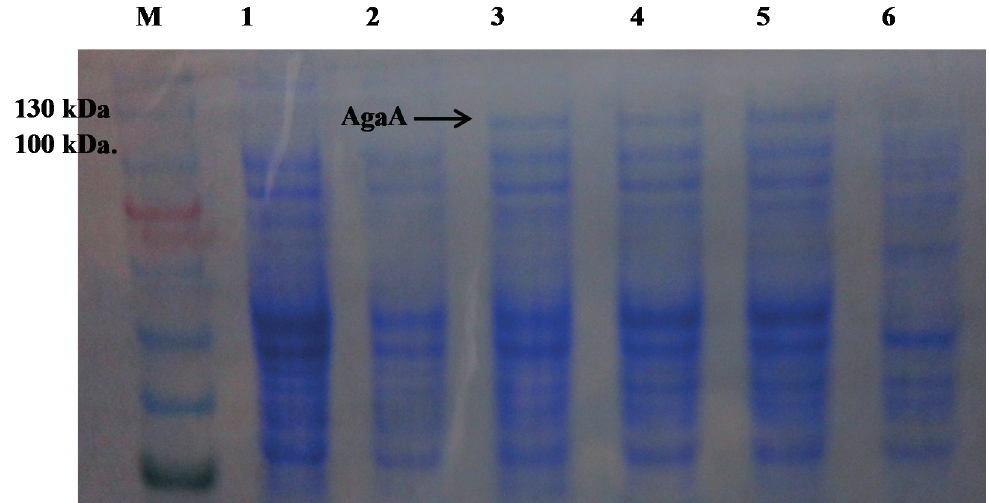
Figure 3. The sodium dodecyl sulfate polyacrylamide gel electrophoresis (SDS-PAGE) of overexpressed pET-AgaA- Δ SP at various temperatures. Lane M , protein marker; Lane 1 , C43 (DE3) harboring an empty plasmid; Lane 2 , uninduced C43 (DE3)/pET-AgaA- Δ SP; Lane 3 – 6 , C43 (DE3)/pET-AgaA- Δ SP induced with 0.2 mM IPTG at different temperatures, respectively (16, 20, 24 and 37 °C). The E. coli cells harboring pET-AgaA- Δ SP were induced by 2 mM IPTG at various temperatures for 12 or 6 h (37 °C), and the overexpression of AgaA- Δ SP were analyzed by using